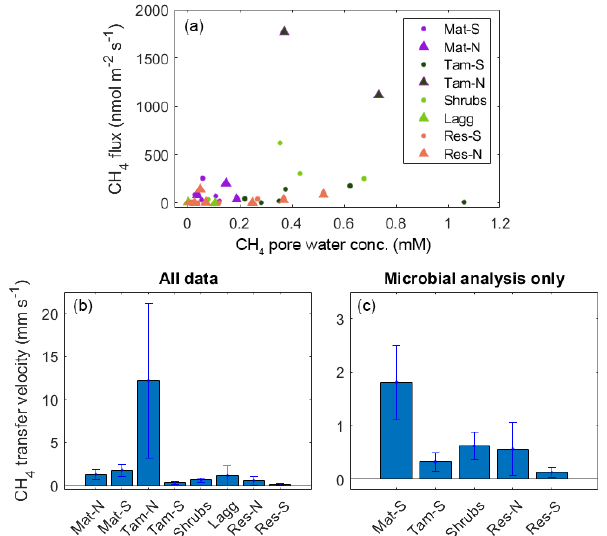
Figure 7. (a) Relationship between CH 4 pore-water concentration and CH 4 flux for times where the WL was high and within the top stratigraphic layer of the peat. (b) CH 4 transfer velocity calculated from the upper plot; (c) same as previous, but with the data relevant for microbial analysis only. Note that microbial samples for Tam- N, Mat-S, and Lagg are not available and therefore not used in the following comparisons of CH 4 transfer velocity against microbial activity. The error bars are the standard